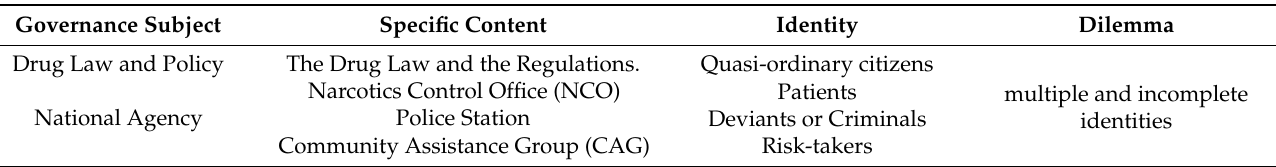
Table 2. Multiple governance and identity